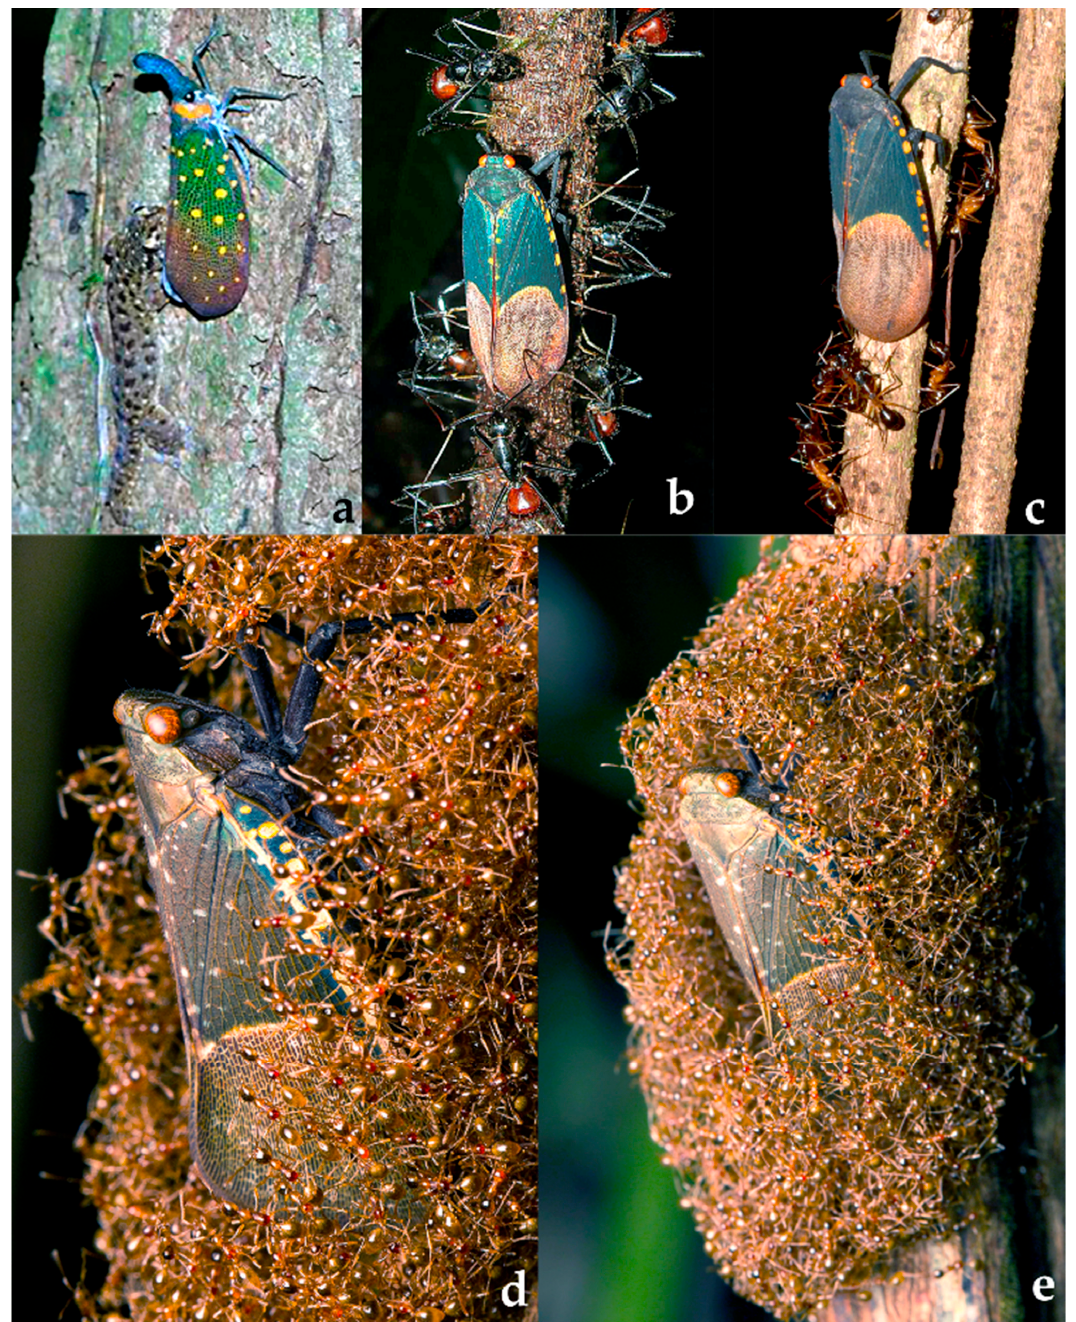
Figure 19. Fulgoridae: ( a ) Pyrops whiteheadi (Distant, 1889) tended by Reptilia: Squamata: Gekkonidae indet., Malaysia: Borneo, Sabah, Sandakan, 05°50 ′ N 118°07 ′ E, 13.05.2015, adult on tree trunk, obs. R.K. Asuncion; ( b ) Scamandra polychroma Gerstaecker, 1895 tended by Formicidae: Formicinae: Dinomyrmex gigas (Latreille, 1802), Malaysia: Borneo, Sarawak, Mulu National Park, 4°7 ′ 55 ″ N 114°55 ′ 8 ″ E, 1.05.2006, adult on tree trunk, obs. D. Mezger; ( c ) S. polychroma tended by Formicidae: Formicinae: Camponotus sp., Malaysia: Borneo, Sarawak, Mulu National Park, 4°7 ′ 55 ″ N 114°55 ′ 8 ″ E, 28.06.2014, adult on tree trunk, obs. A. Kang; ( d , e ) S. polychroma tended by Formicidae indet., Malaysia: Borneo, Sarawak, Mulu National Park, 4°7 ′ 55 ″ N 114°55 ′ 8 ″ E, 20.09.2015, adult on tree trunk, obs. P. Soltys.